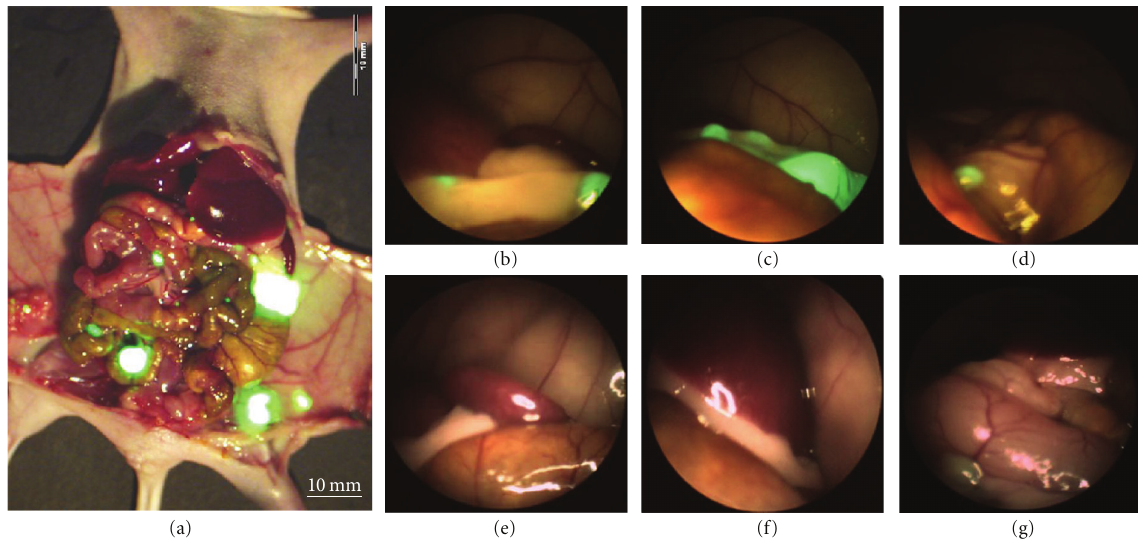
Figure 1: Comparative identification of tumor foci under brightfield and fluorescence laparoscopy. (a) OV100 open image from a representative mouse. View of left upper quadrant in a mouse specimen under FL (b–d) and BL (e–g). The green fluorescence of the metastatic lesions are unmistakable under FL, whereas under BL the tumor foci resembled normal tissue and were not identifiable. BL: brightfield laparoscopy; FL: fluorescence laparoscopy